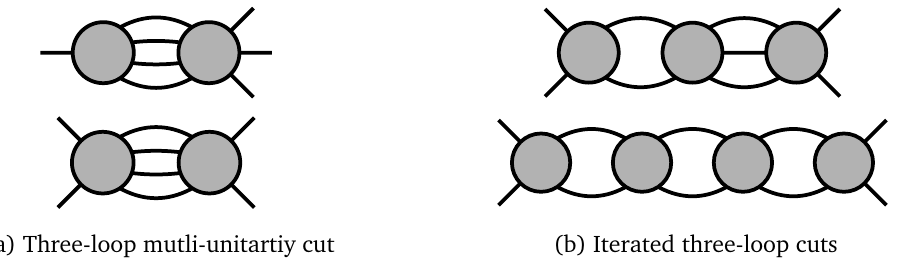
Figure 4: Cut topologies considered in the UV construction of the three-loop four- point amplitude in N = 8